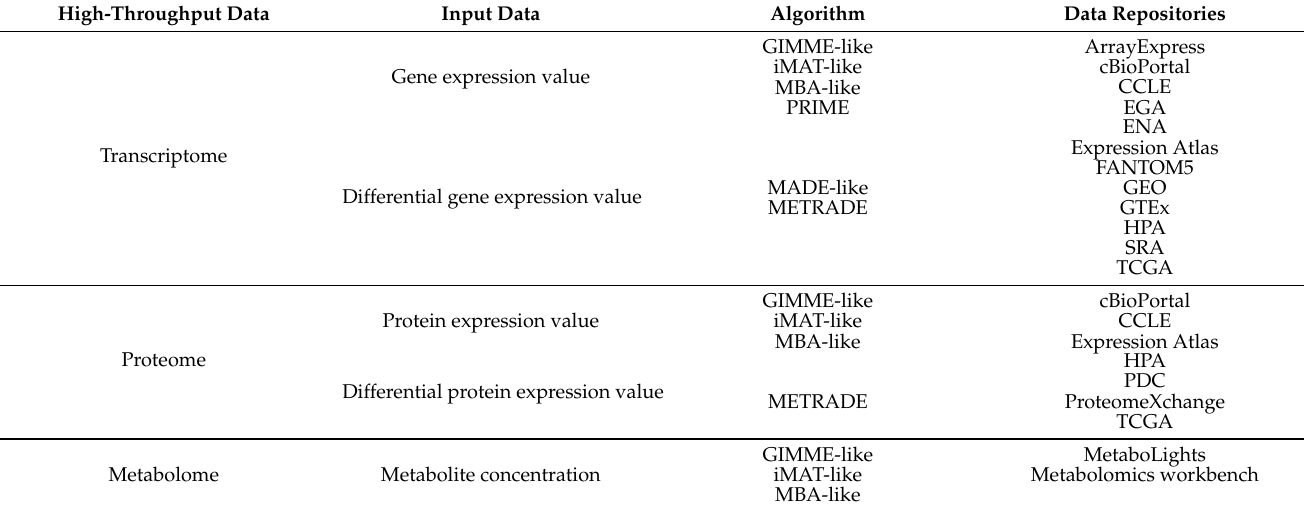
Table 3. The types of high-throughput data, their use and available